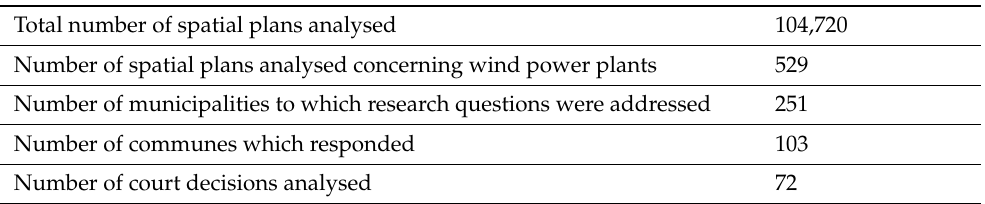
Table 3. Description of the data used in the